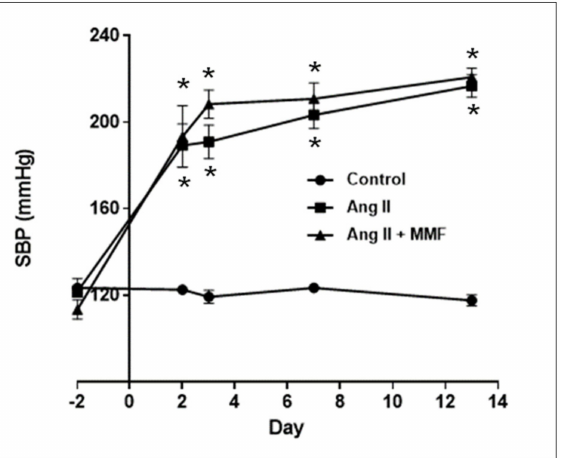
Figure 1. Effects of MMF on blood pressure. SBP was measured by a tail-cuff plethysmography system on day − 2, 2, 3, 7 and 13. Mean ± SE. n = 6 in each group. Asterisk ( p < 0.05) indicates significant difference compared to the control group at each time